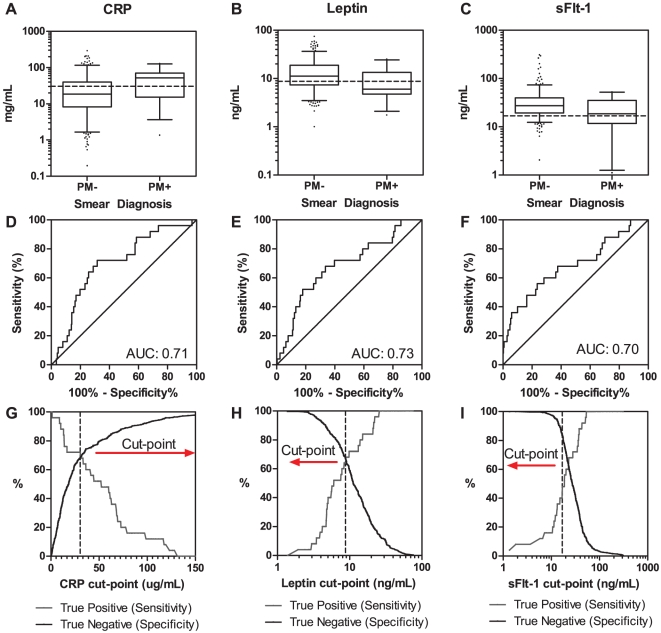
Biomarkers of Occult Placental Malaria Infection.(A-C) Box plots showing the median (IQR) of peripheral blood biomarkers (whiskers denote the 5-95% percentiles and outliers are plotted as dots), with the associated (D-F) receiver operating characteristic (ROC) curves and (G-I) decision plots of sensitivity and specificity generated from the ROC curves. Diagnostic accuracy was assessed using receiver operating characteristic (ROC) curves and determining the area under the ROC curve (AUC). The AUC were compared and all three biomarkers had comparable diagnostic performance (method of Delong et al.). The dotted lines represent the cut-point for dichotomizing the biomarkers, as defined using the Youden index.